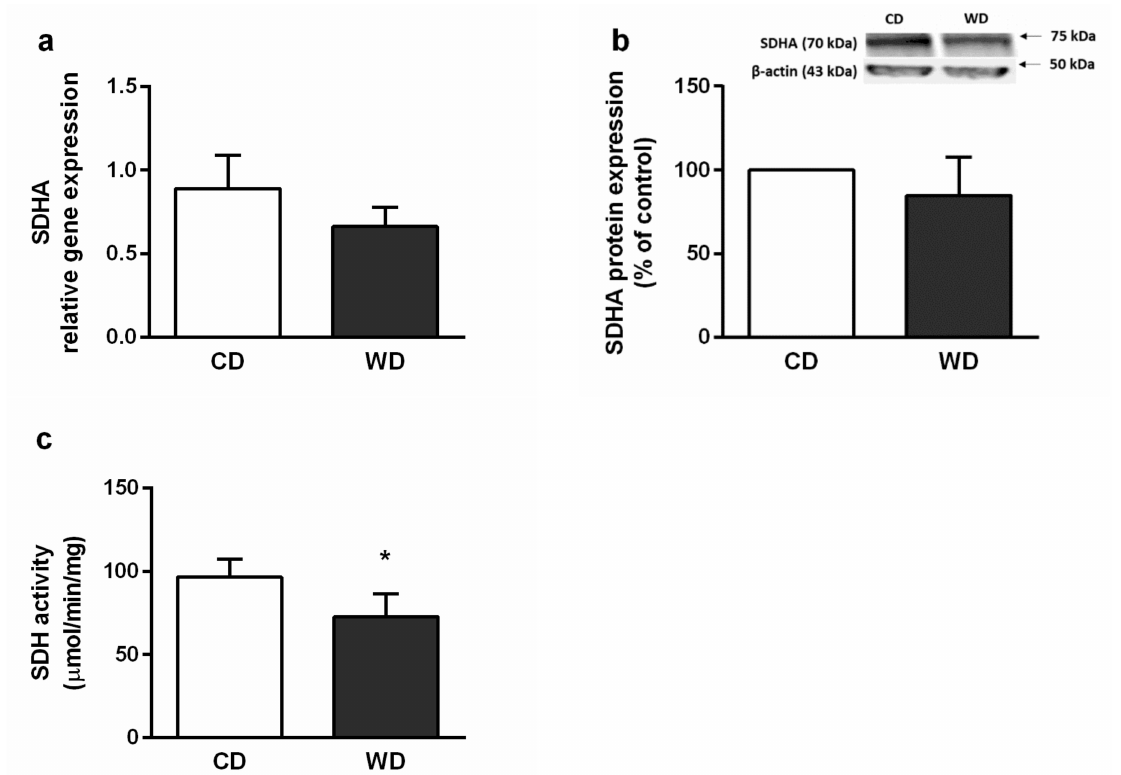
Figure 10. Hepatic succinate dehydrogenase (SDH) in mice fed a control diet (CD) and a Western-style diet (WD). ( a ) SDH subunit A (SDHA) relative gene expression. ( b ) SDH subunit A protein expression. ( c ) SDH enzymatic activity. The results are expressed as the means ± SD; * p < 0.05 ( n = 4–6 each